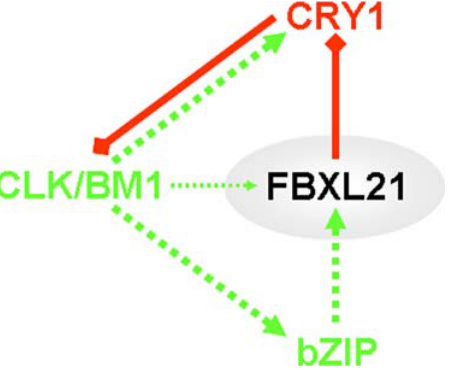
Figure 7. A model for Fbxl21 function in the mammalian circadian clock. Transcriptional control (green dashed line) by CLK/ BM1 directs rhythmic expression of Cry1 and the PAR-bZIP and also has a modest effect upon Fbxl21 . Transcription of Fbxl21 mostly depends on the PAR-bZIP proteins. The FBXL21 protein in turn controls degradation of CRY1 (red diamond-ended line) and therefore exerts a pivotal role in the control of CRY1-mediated inhibition of CLK/BM1 transcription (red diamond-ended